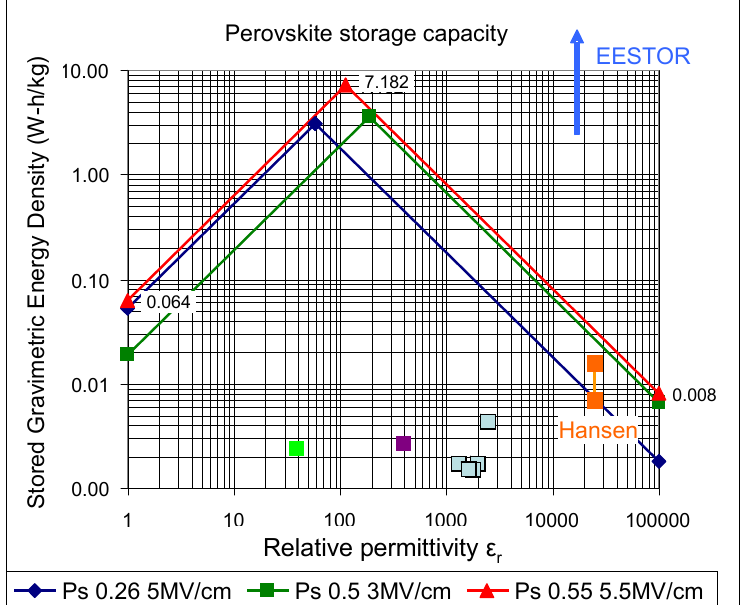
Figure 10. Plot of log energy density vs . log relative permittivity for modified barium ) and breakdown voltages. Also shown are titanates with different assumed polarization (P s thin-film (TF) capacitor data measured in this work, barium titanate (BTO) composite data from the University of Halle-Wittenberg and data from the literature (Hansen